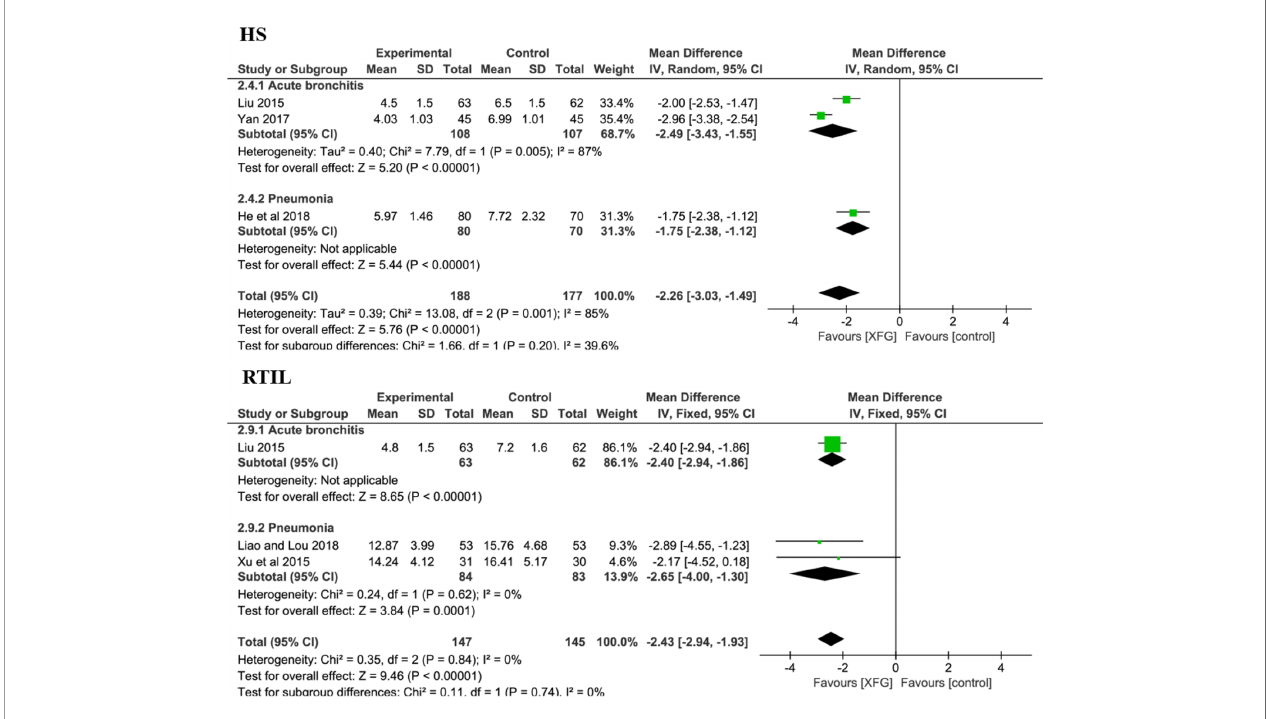
FIGURE 7 | Forest plot and subgroup analysis of the HS and